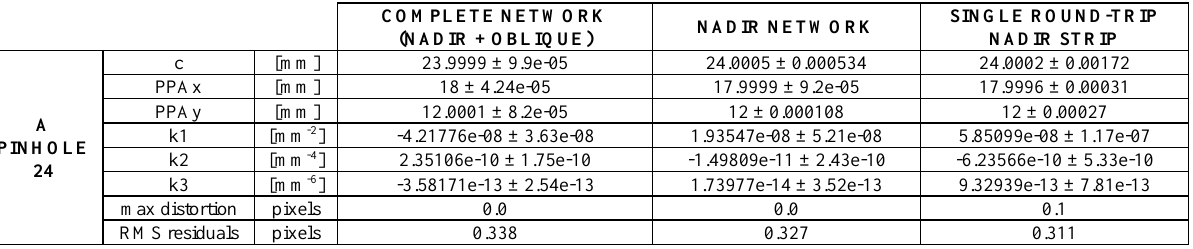
Table 1. Results of the bundle adjustment with self-calibration for the simulated dataset A Pinhole 24 acquired with a pinhole